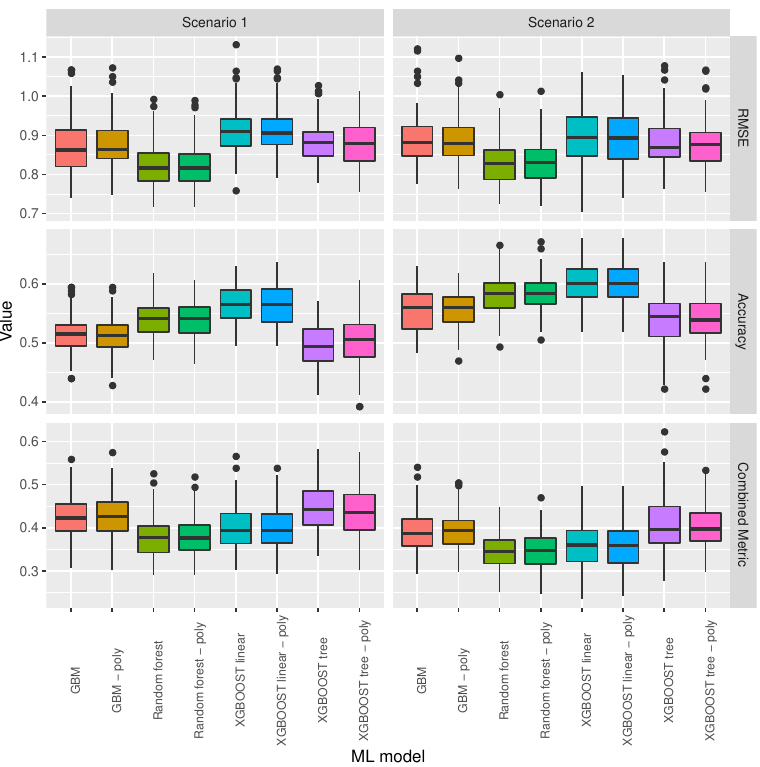
Figure 7. Model selection for the scenarios specified in Table